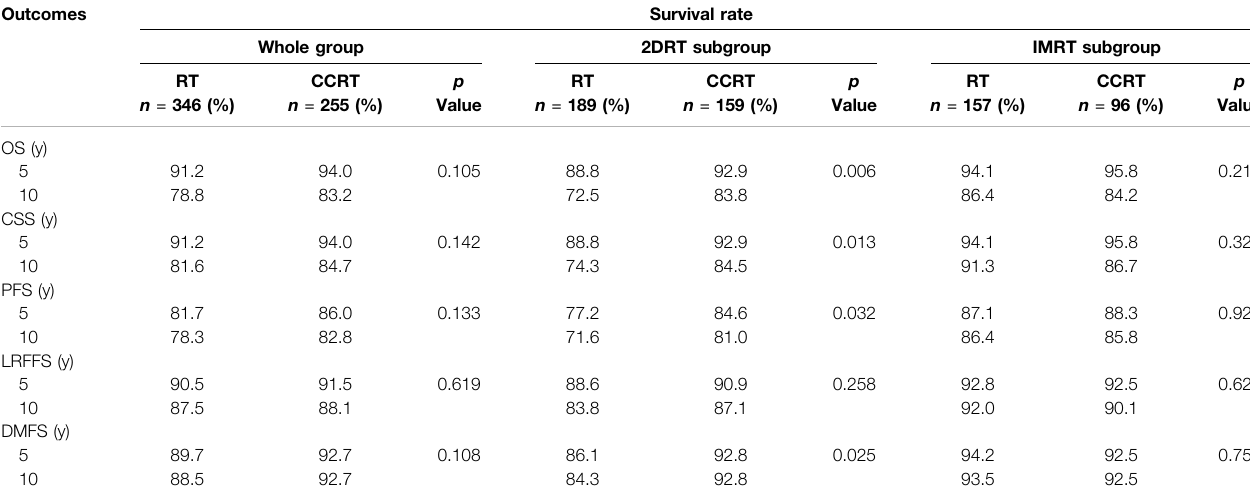
TABLE 2 | Comparison of survival outcomes between the RT and CCRT groups in three analysis levels. Outcomes Survival rate Whole